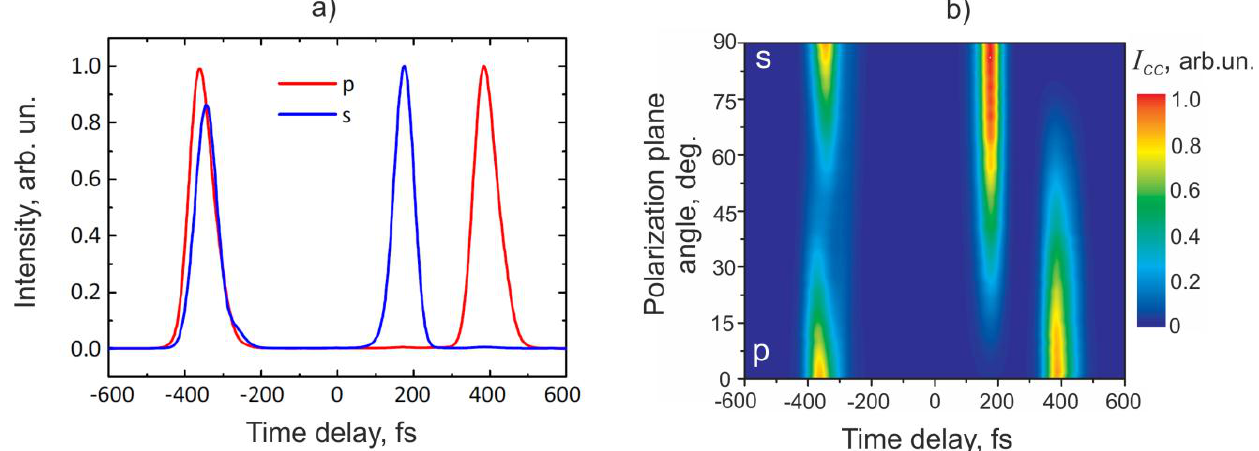
Figure 3. ( a ) Cross-correlation functions measured for the p - and s -polarized fundamental radiation and ( b ) as a function of the angle between the polarization plane of the fundamental radiation and the plane of